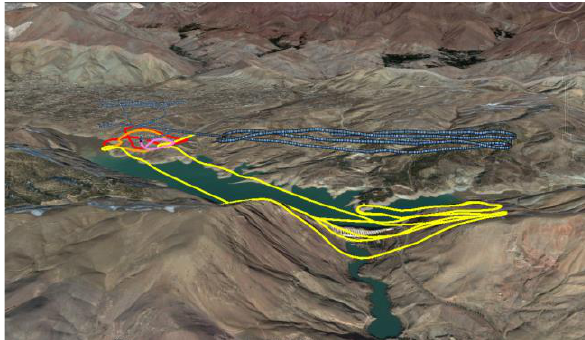
Figure 3. Planned flight path over an mountainous area